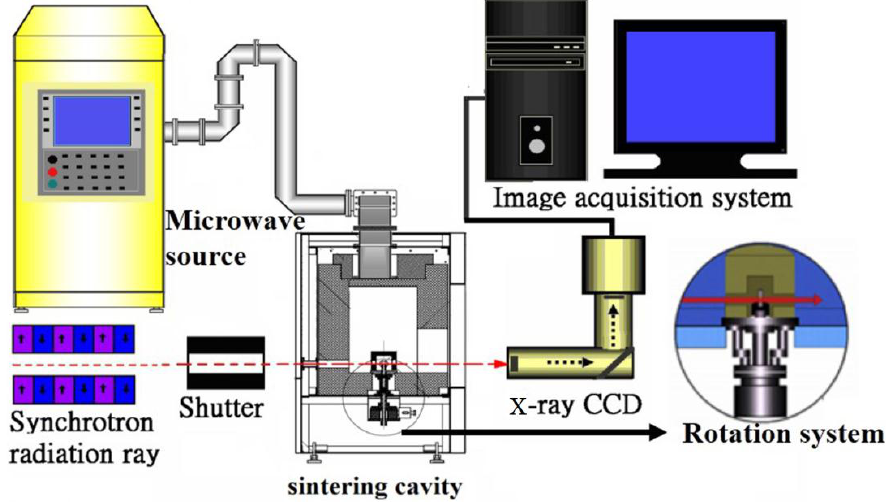
Figure 1. Schematic of in situ synchrotron radiation computed tomography (SR-CT) system of microwave sintering.